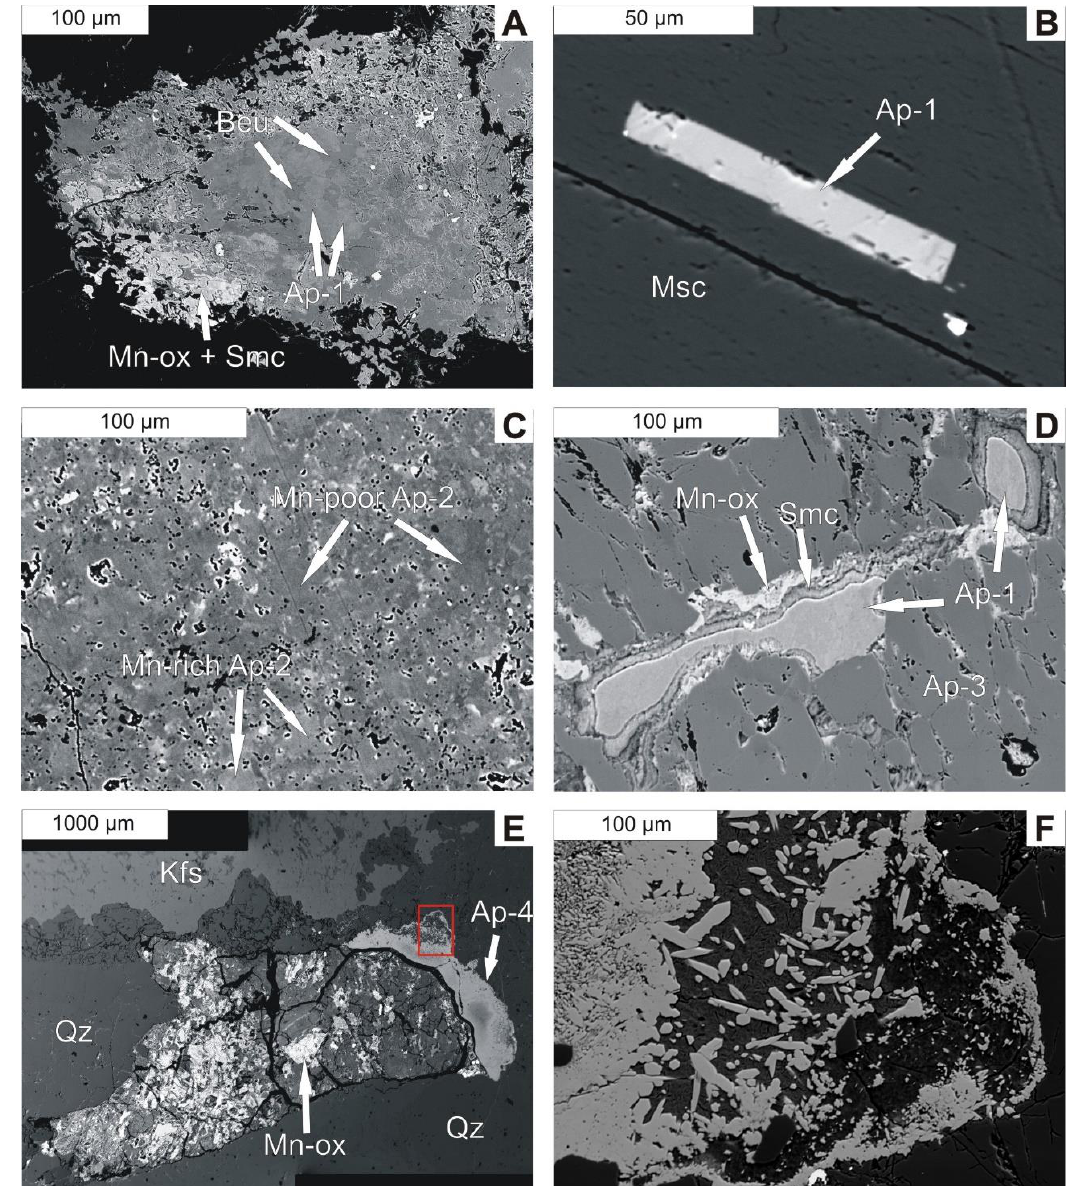
Figure 2. BSE (backscattered electron) images of apatites from the Szklary pegmatite. ( A ) Type 1 apatite with stoichiometry of pieczkaite intergrown with beusite and partly altered to secondary smectites and Mn oxides (sample Sz108); ( B ) Euhedral Type 1 apatite in muscovite (sample Sz79); ( C ) Patchily zoned Type 2 apatite with the domains compositionally similar to Type 1 intergrown with Cl-rich domains of markedly lower Mn contents and trace amounts of F (sample Sz29); ( D ) A relic of the Type 1 apatite rimmed by secondary smectites and Mn oxides and overgrown by Type 3 of Mn-rich fluor- to hydroxylapatite; ( E ) Panorama for a strongly digested relic of a serpentinite xenolith with Type 4 apatite (sample Sz132) formed along its margin. Red box marks the area enlarged and rotated in the image F; ( F ) Aggregate of the Type 4 crystal with the composition of Mn-poor chlorapatite.